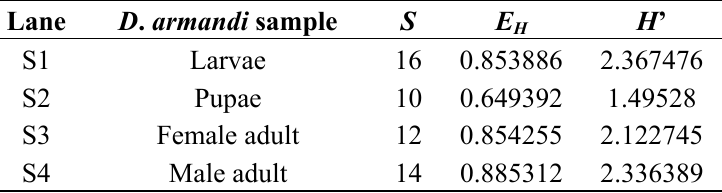
Table 1. Richness ( S ), Evenness ( E ) and Shannon-Wiener index ( H ’) of intestinal symbiotic H bacteria identified in samples of Dendroctonus armandi at different developmental